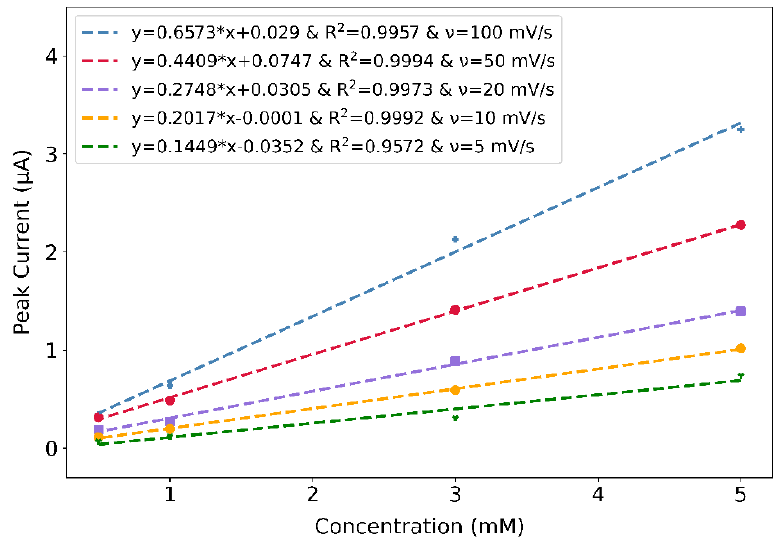
Figure 5. Calibration graphs for various scan rates (legend), taken as the peak oxidative current vs. the concentration of potassium ferricyanide, based on the CV curves of Figure 3, obtained using on-chip Au electrodes.